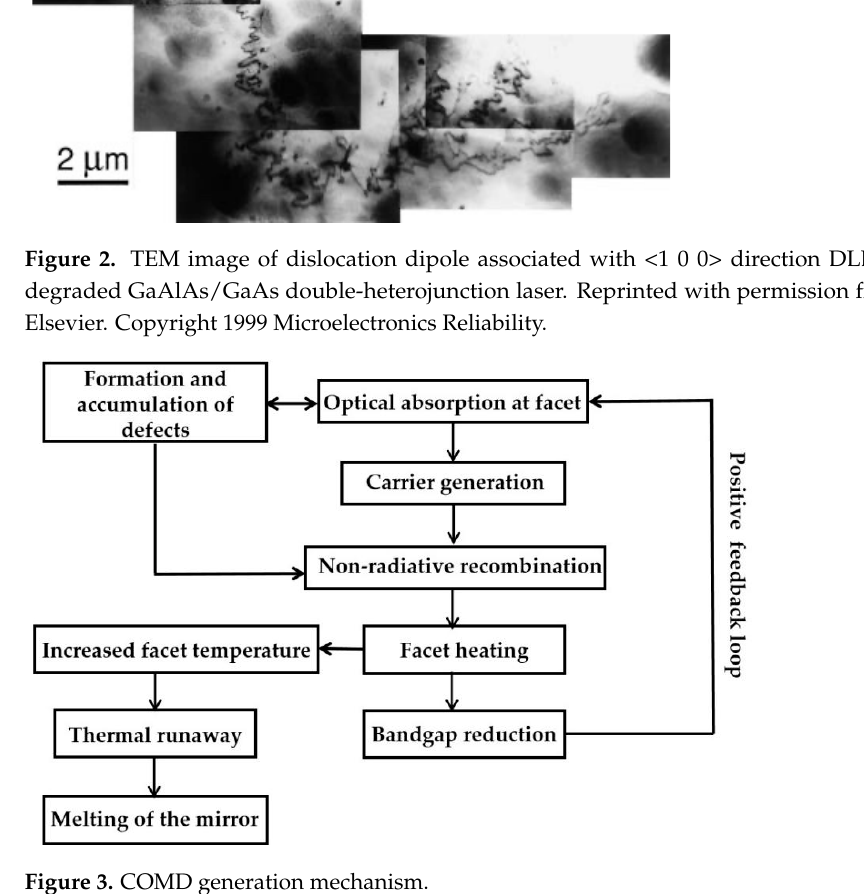
Figure 2. TEM image of dislocation dipole associated with <1 0 0> direction DLD in a rapidly de- graded GaAlAs/GaAs double-heterojunction laser [25]. Reprinted with permission from ref. [25] © Elsevier. Copyright 1999 Microelectronics Reliability.